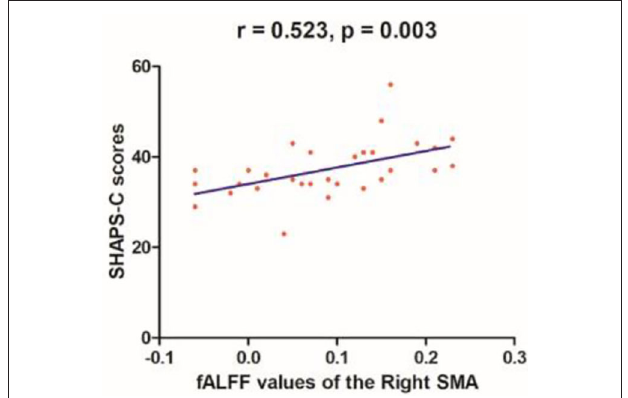
FIGURE 6 | Correlations between fALFF values of the left anterior cingulate cortex (ACC) and TEPS contextual consummatory scores ( r = 0.270, p = 0.041) and TEPS total scores ( r = 0.295, p = 0.025) in all patients.